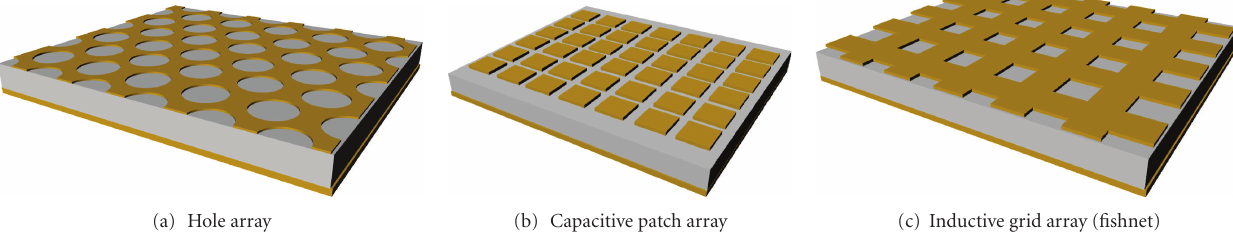
Figure 13: Designs less sensitive to polarization e ff ects.